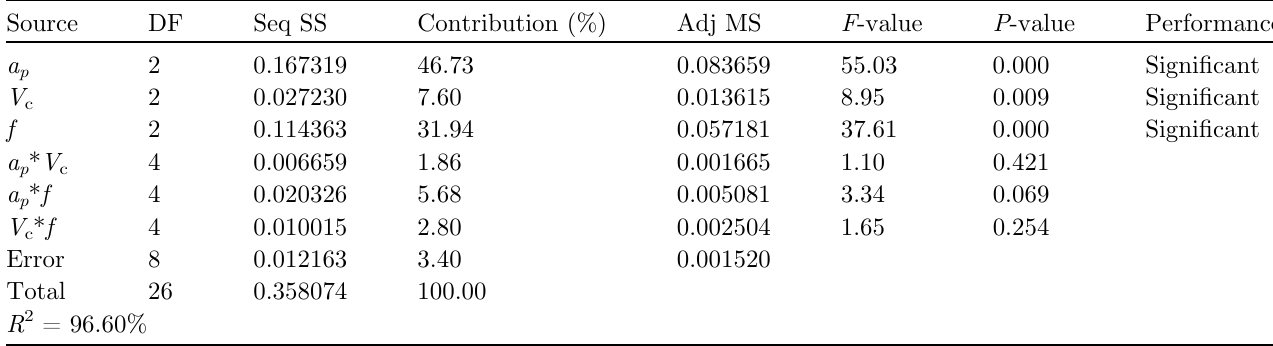
Table 6. Analysis of variance results for fl ank wear (CT).